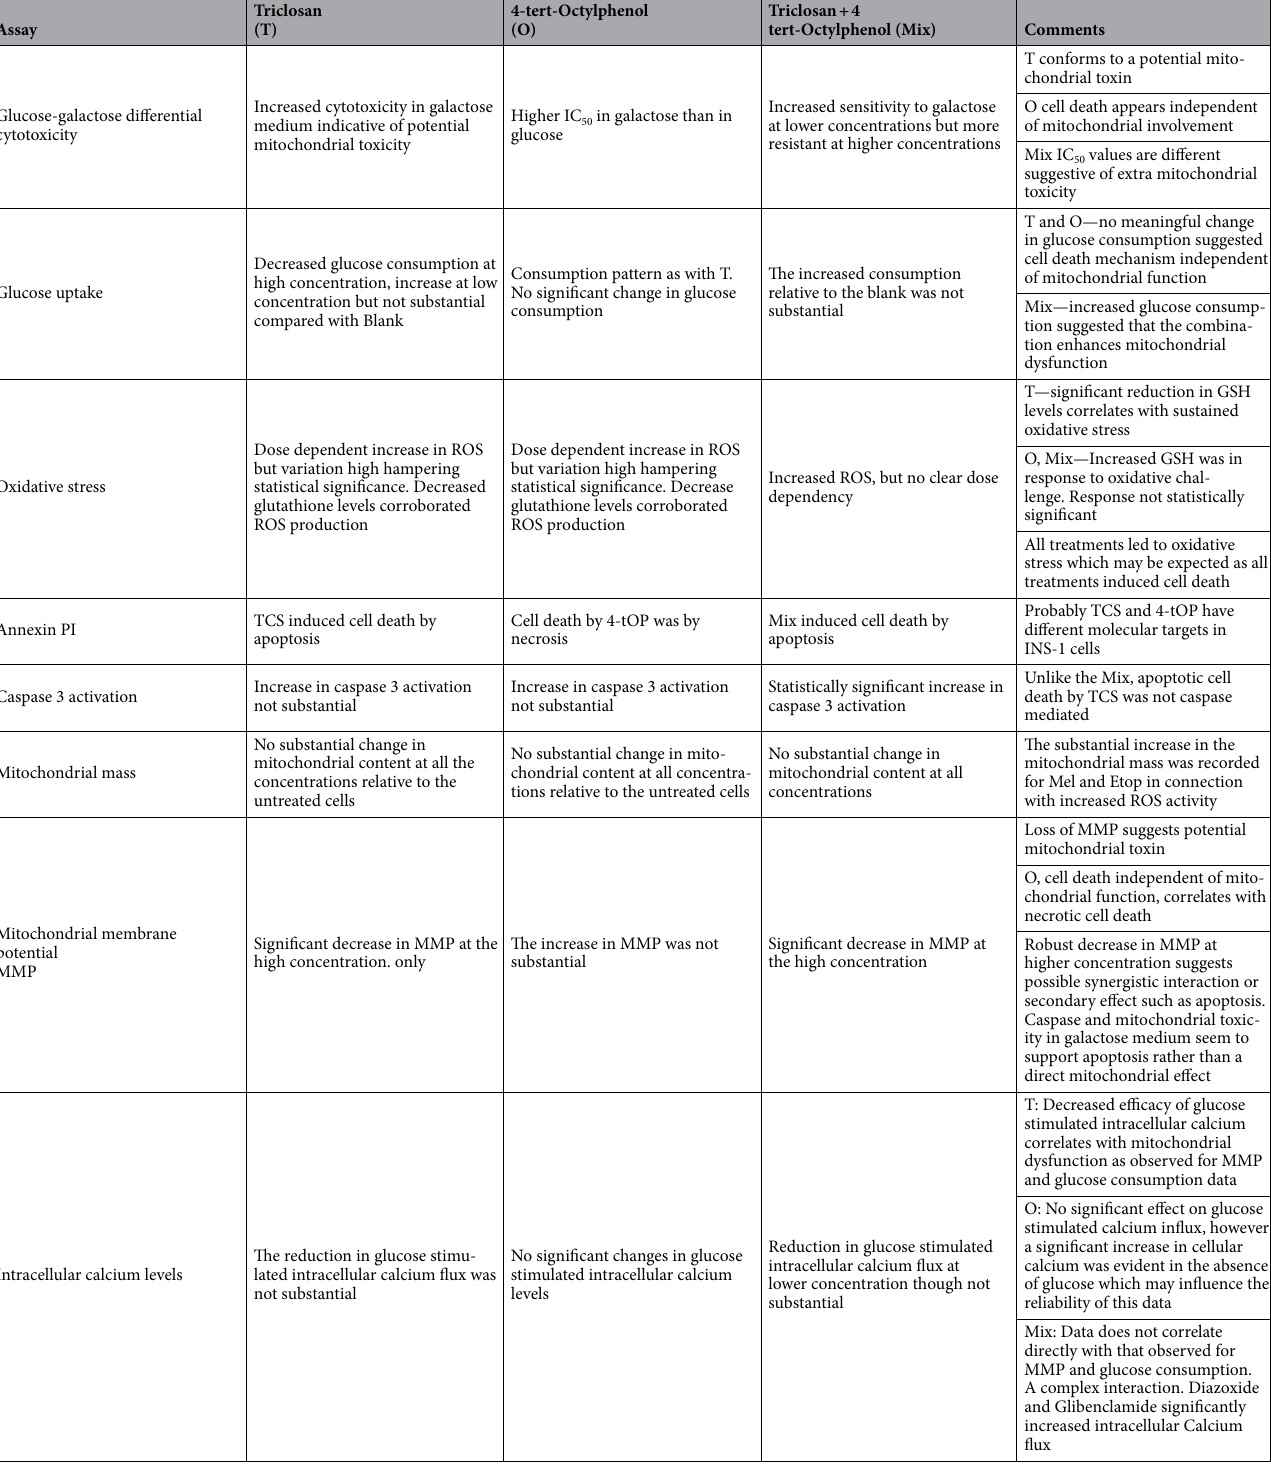
Table 3. Summary of the